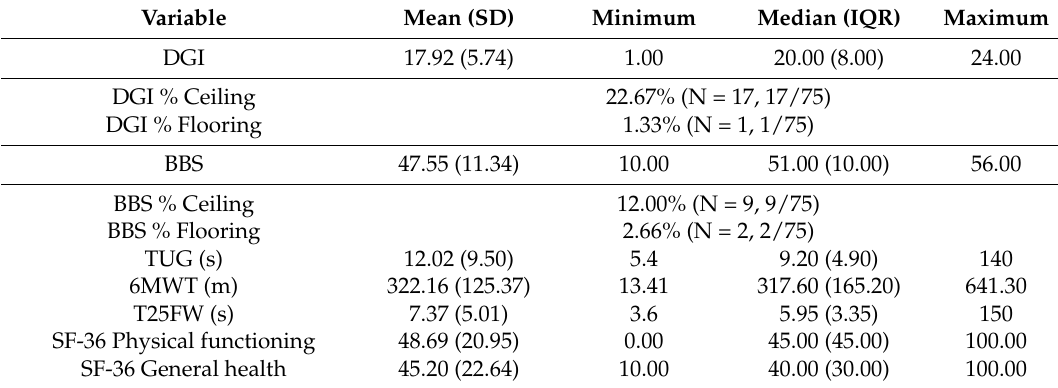
Table 2. Descriptive characteristics of the measures of physical function, physical activity, and balance of the 75 older adults with multiple sclerosis. DGI = Dynamic Gait Index; BBS = Berg Balance Scale; TUG = Timed Up and Go; 6MWT = Six-Minute Walk Test; T25FW = Timed 25-Foot Walk; SF-36 = 36-Item Short Form Health